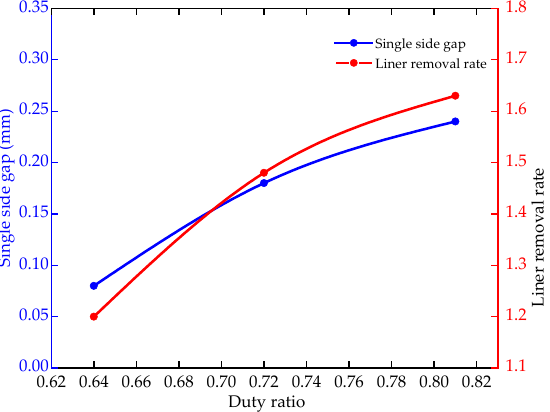
Figure 16. The single side gap and linear removal rate at various duty ratios.